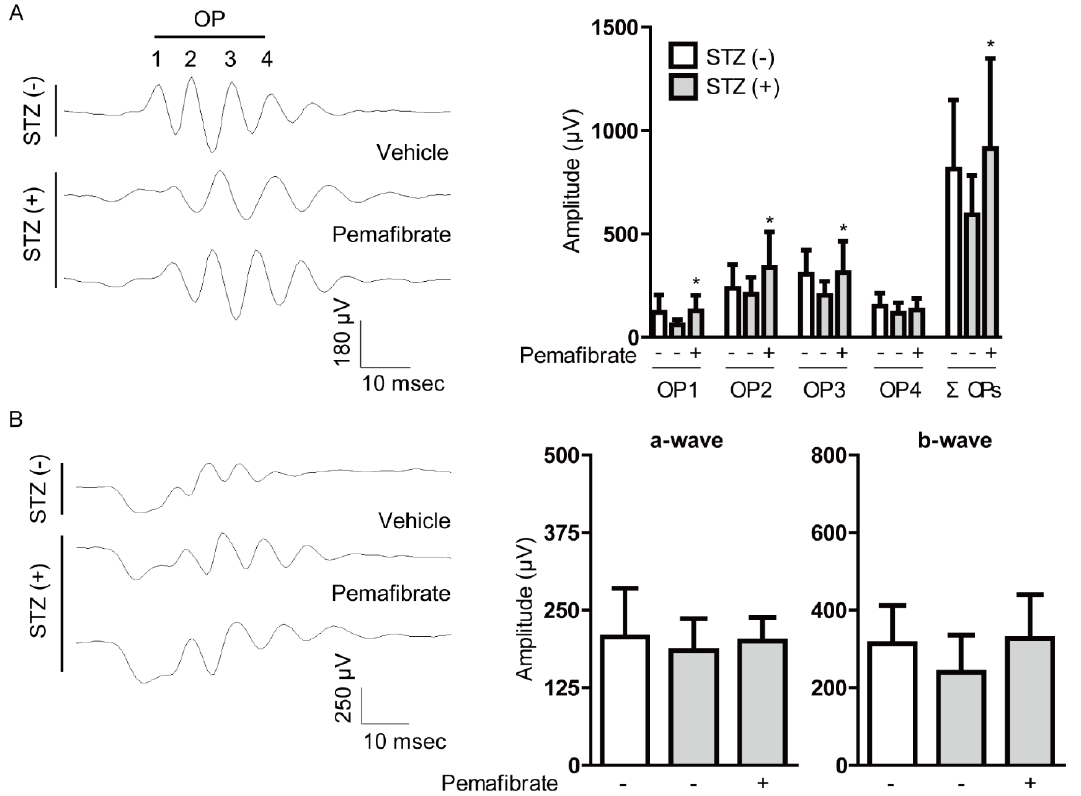
Figure 2. Change of visual function by pemafibrate in the STZ-induced diabetic mouse model. ( A ) Representative waveforms of OPs and quantitative analysis showed that pemafibrate reversed the reduction of OPs (OP1, OP2, OP3, and ΣOPs) amplitudes in STZ-induced diabetic mice ( n = 10–16 per group). ( B ) Representative waveforms of a- and b-waves and quantitative analysis showed that pemafibrate did not increase the reduced amplitudes of a-wave and b-wave in STZ-induced diabetic mice ( n = 14–18 per group). * p < 0.05, compared with vehicle-administered diabetic mice. Graphs are presented as mean with ± standard deviation. The data were analyzed using one-way ANOVA followed by a Bonferroni post hoc test. OP; oscillatory potential.